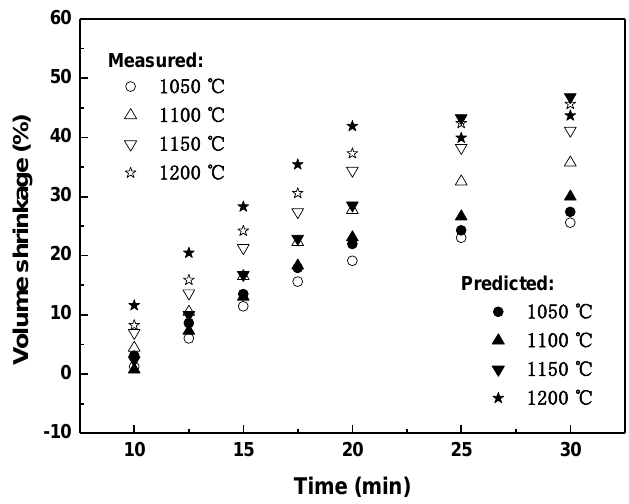
Figure 14. Comparison of measured and predicted volume shrinkage values. Table 4. Root mean square error (RMSE) values.